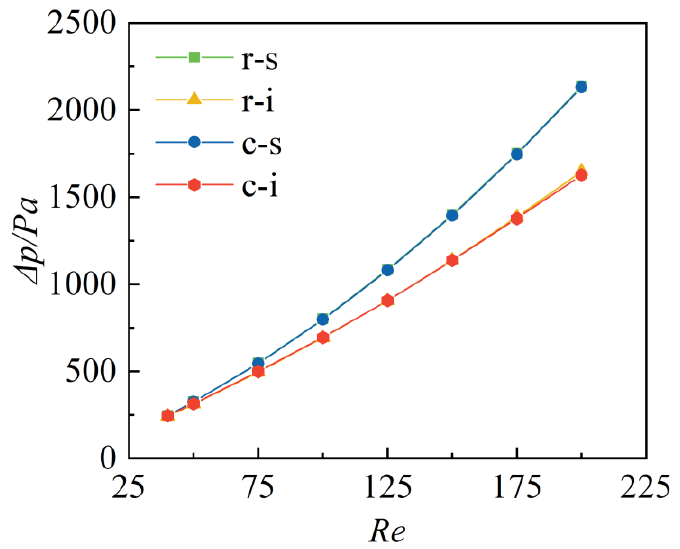
Figure 8. Variations of pressure drop vs. Reynolds number in four channels.